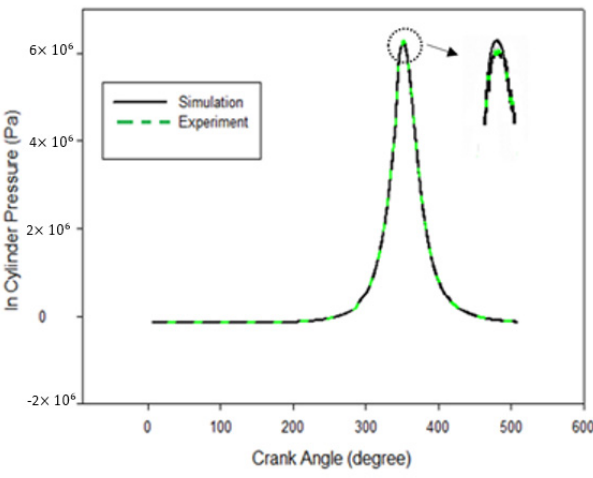
Figure 7. In-cylinder pressure against crank angle ( θ ).